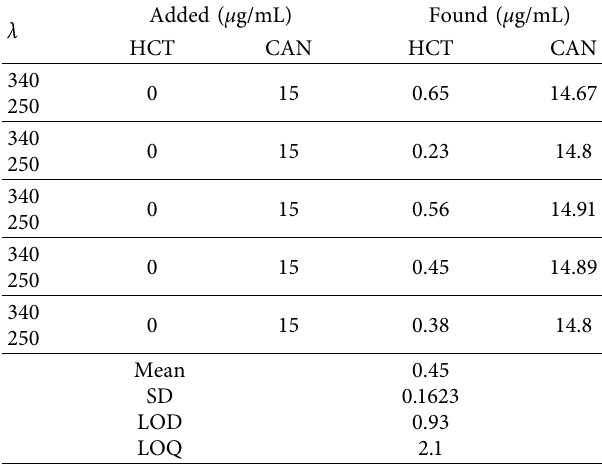
Table 4: Limit of detection (LOD) and limit of quantifcation (LOQ) of HCT by correction absorbance.